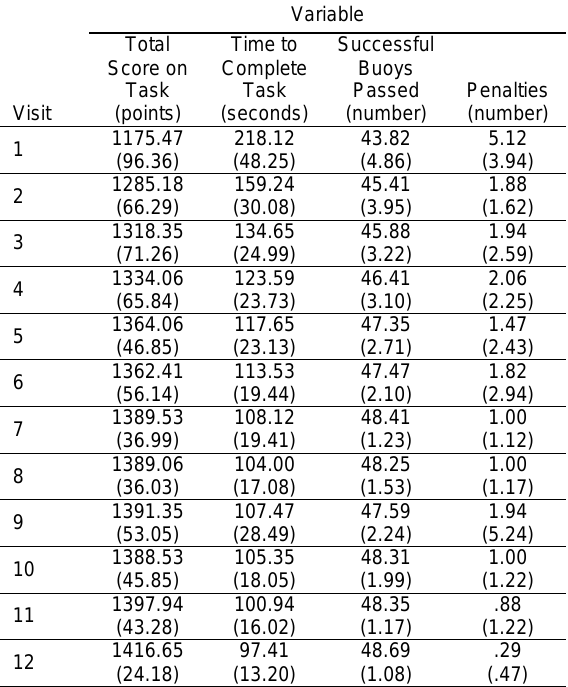
Table 1. Mean (standard deviation) performance